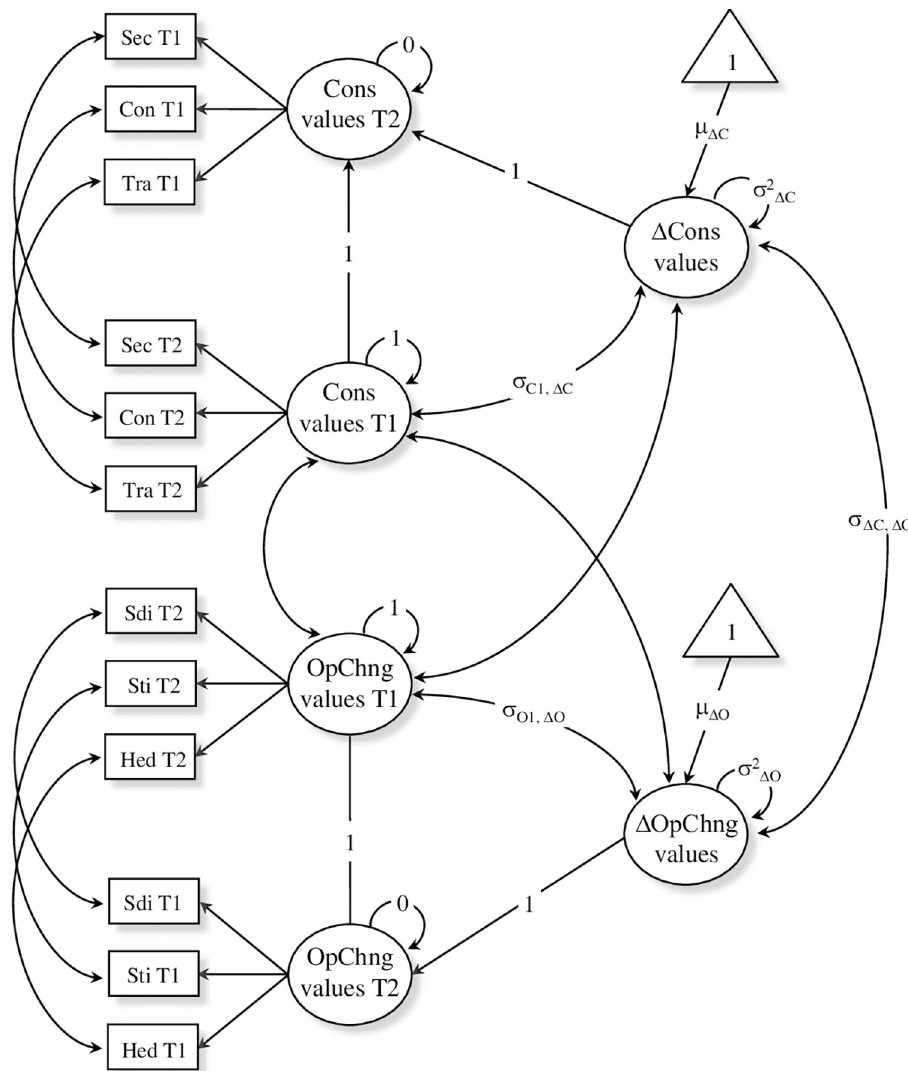
Fig 2. Path diagram of the unconditional LCS model for conservation and openness to change values. Sec = Security; Con = Conformity; Tra = Tradition; Sdi = Self-direction; Sti = Stimulation; Hed = Hedonism; Cons = Conservation; OpChng = Openness to